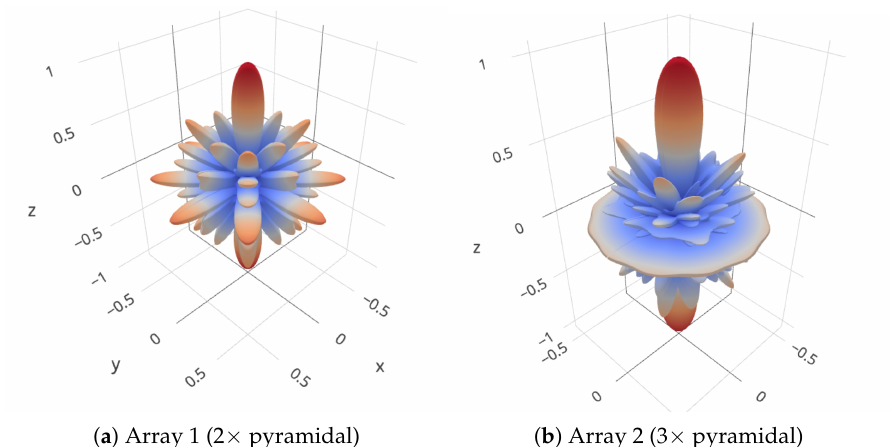
Figure 5. Examples of ambiguity in the directivity pattern for arrays 1 and 2 at frequency f = f max , once steered towards the θ = 0